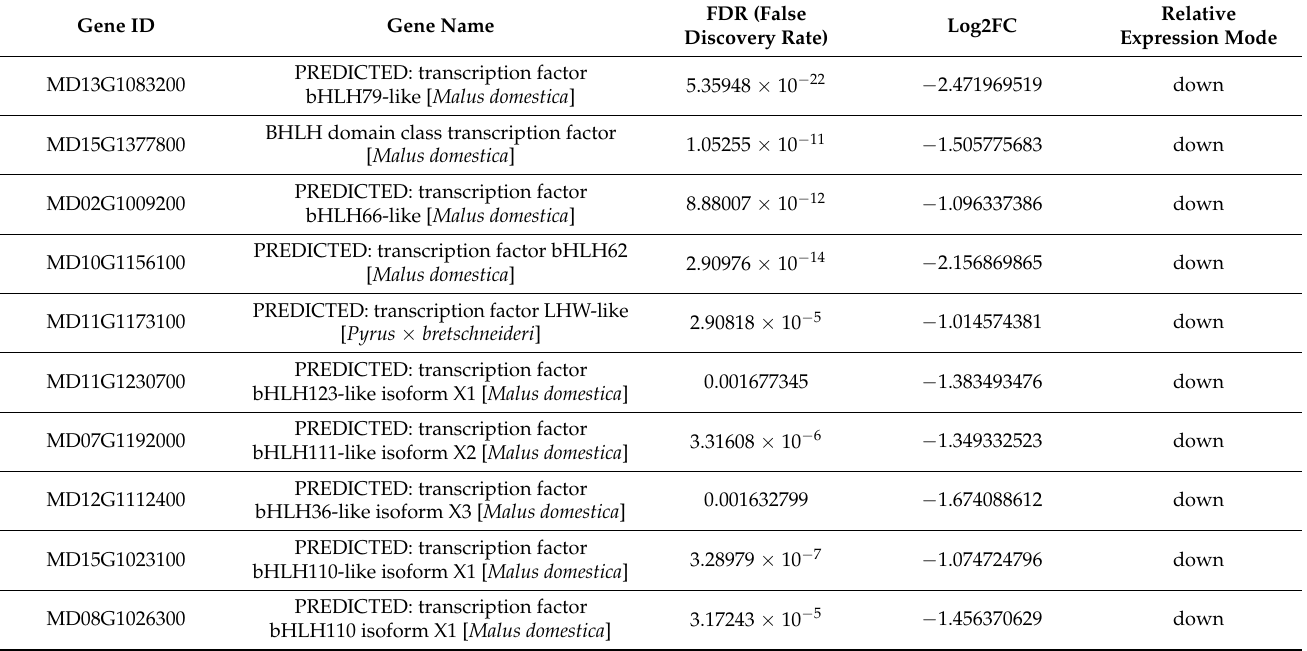
Table 1. Differentially expressed MYB transcription factors in LF and GLF